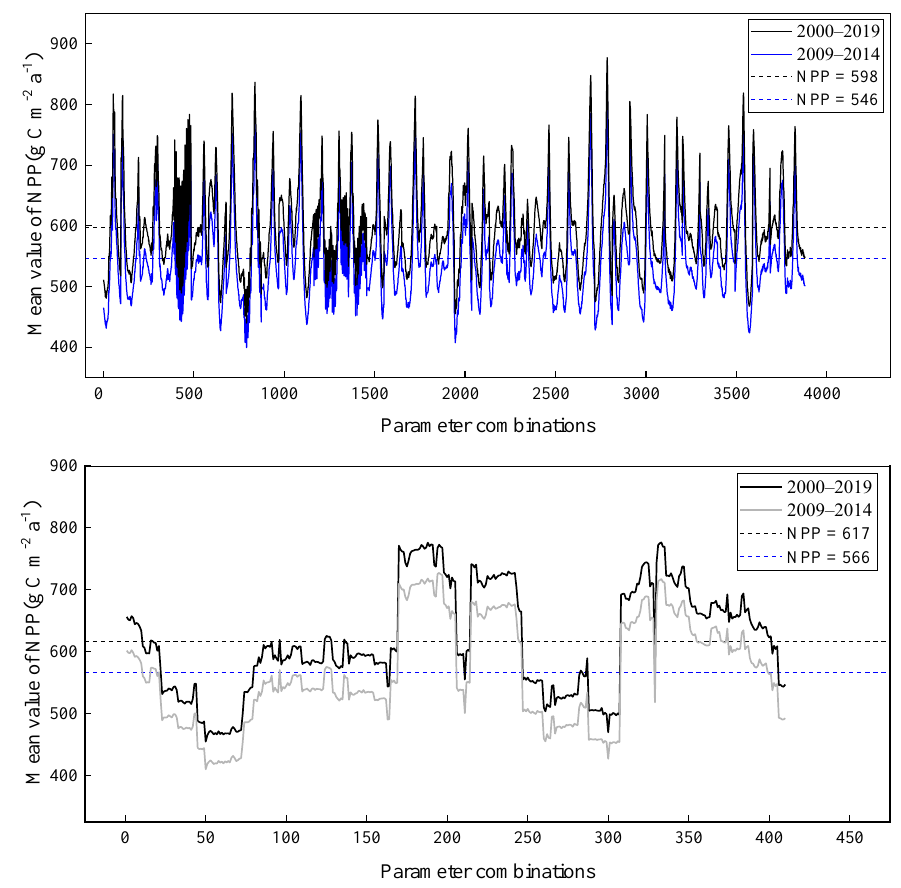
Figure 3. NPP of all parameter combinations based on the EFAST and Morris method.